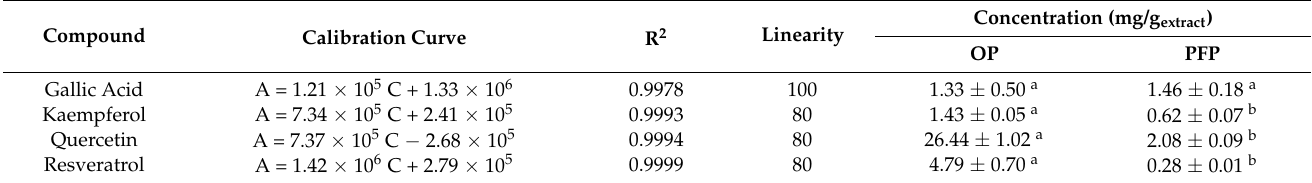
Table 2. HPLC/DAD analysis results: calibration curve, coefficient of determination (R 2 ), linear- ity range and the concentration of each compound in both onion peel extract and passion fruit peel extract.